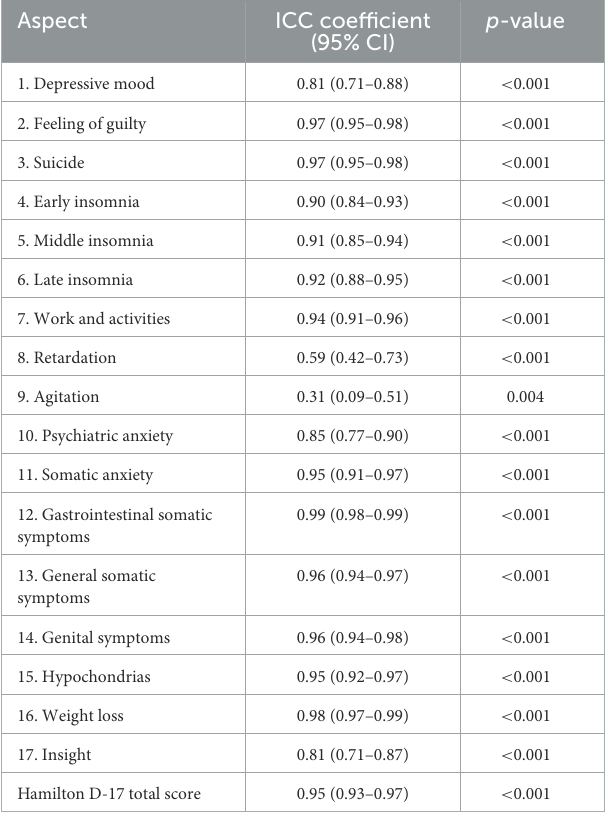
TABLE 3 Inter-rater reliability of the Vietnamese version of the Hamilton D-17 ( N = 70).